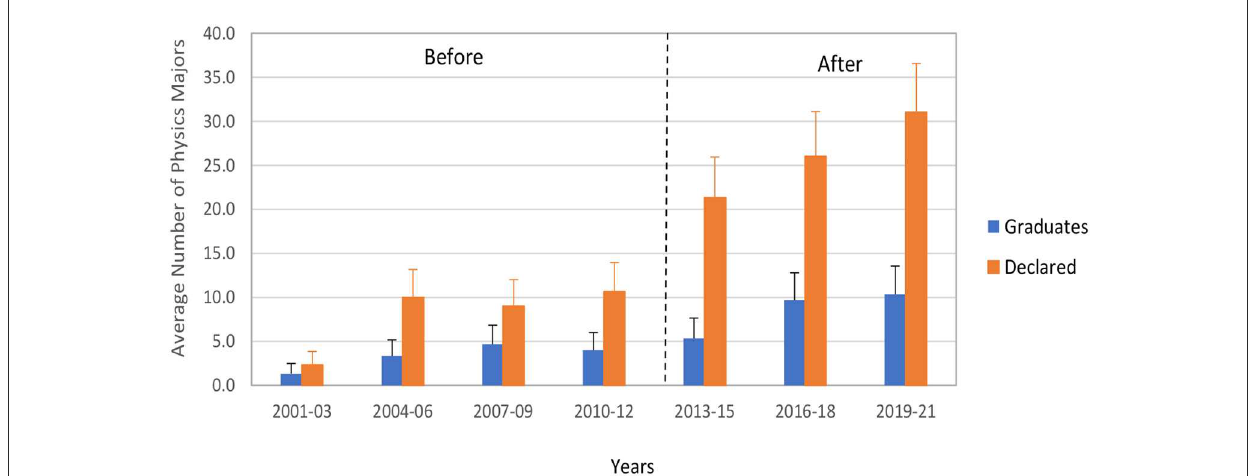
FIGURE1 Three-year averages for the numbers of declared physics majors (“declared”) and the number of undergraduate degree recipients (“graduates”). Differences between the number of declared and the number of graduates are based on the definition of physics majors as discussed in the text (Section 1.2). Vertical dashed line demarcates the beginning of the innovation